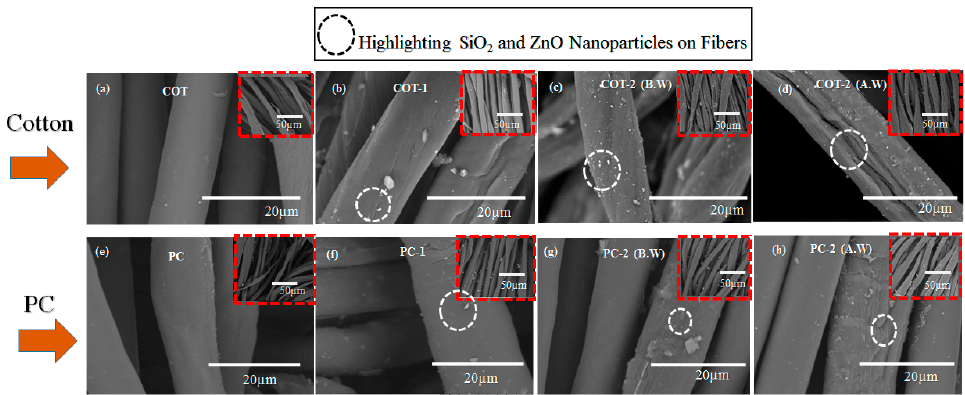
Figure 3. Surface morphology of the treated and untreated samples.